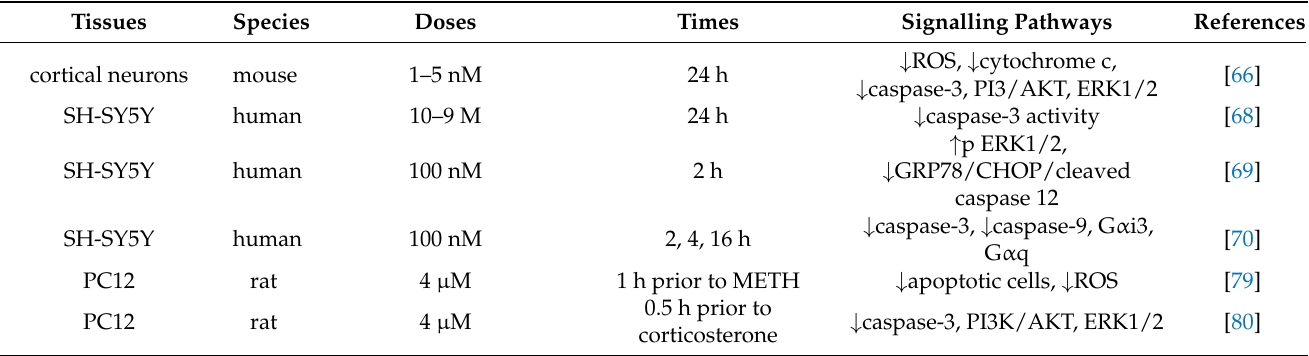
Table 1. Anti-apoptotic effects of apelinergic system. Stimulation, ↑ ; inhibition, ↓ .